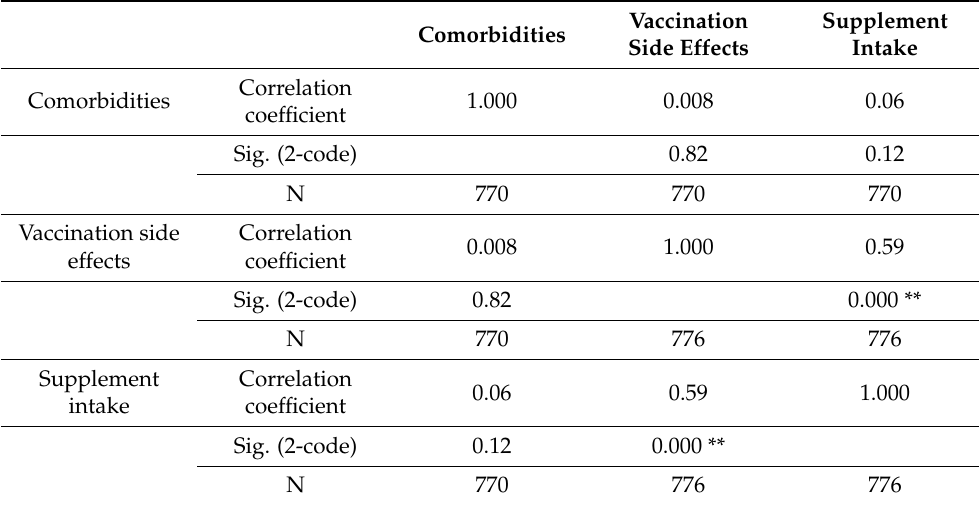
Table 5. Correlation between vaccination side effects, supplement intake, and comorbidities at the end of the vaccination cycle.